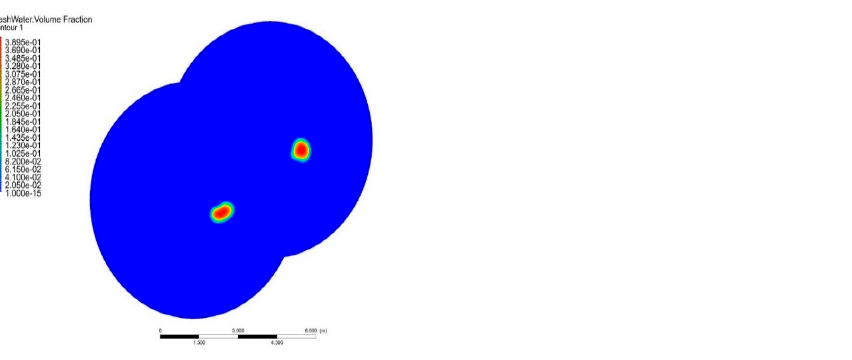
Figure 6. Maximum Volume Fraction values for the Scrubber Wash Water (rough mesh).